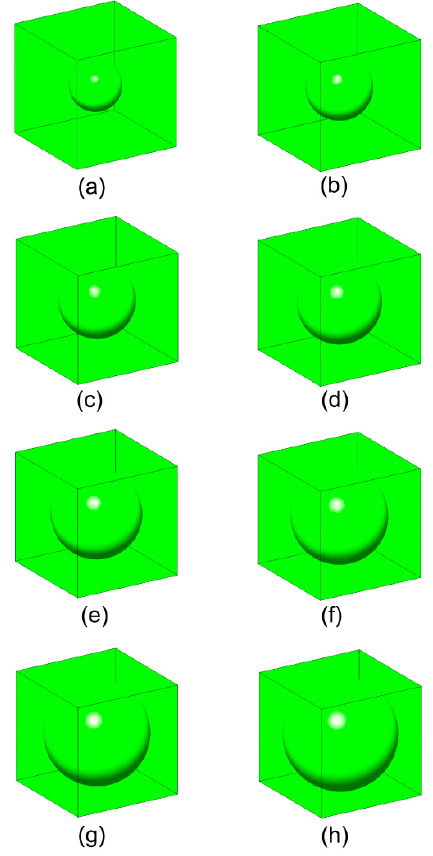
Figure 6. Solid cube with spherical void inclusion for mechanical properties homogenization. Void